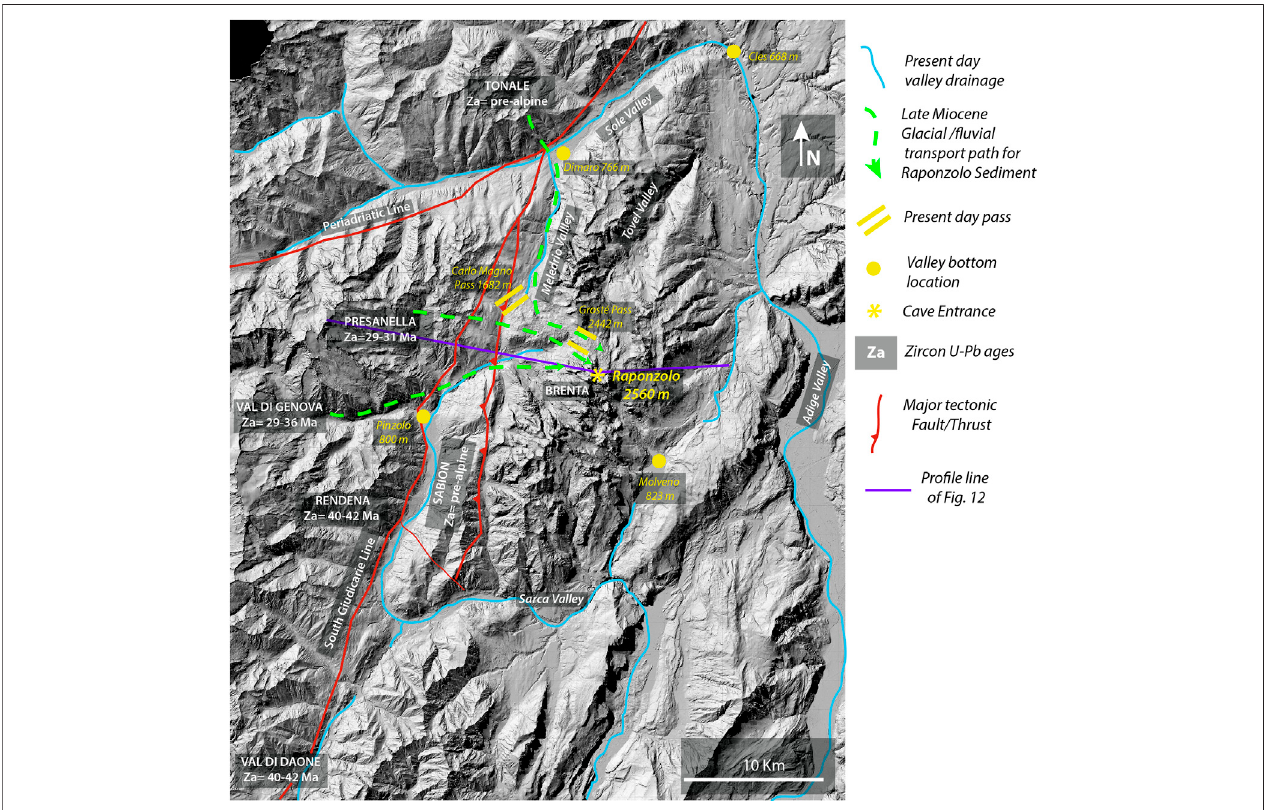
FIGURE 11 | Interpretation of sediment transport path from Adamello/Tonale toward Raponzolo Cave with the present hydrological network, major tectonic lines and U-Pb zircon ages from the different sectors.